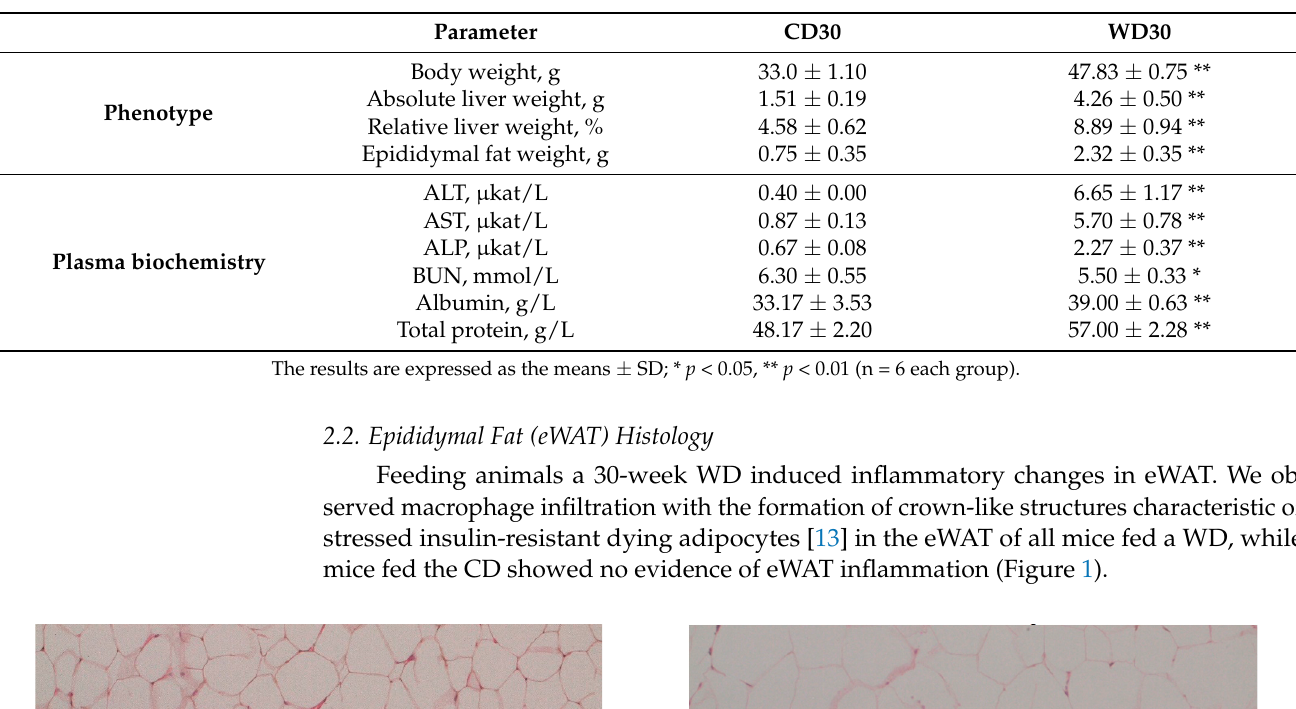
Table 1. Basal phenotype and plasma characteristics in mice fed a control diet (CD30) and Western-style diet (WD30) for 30 weeks.